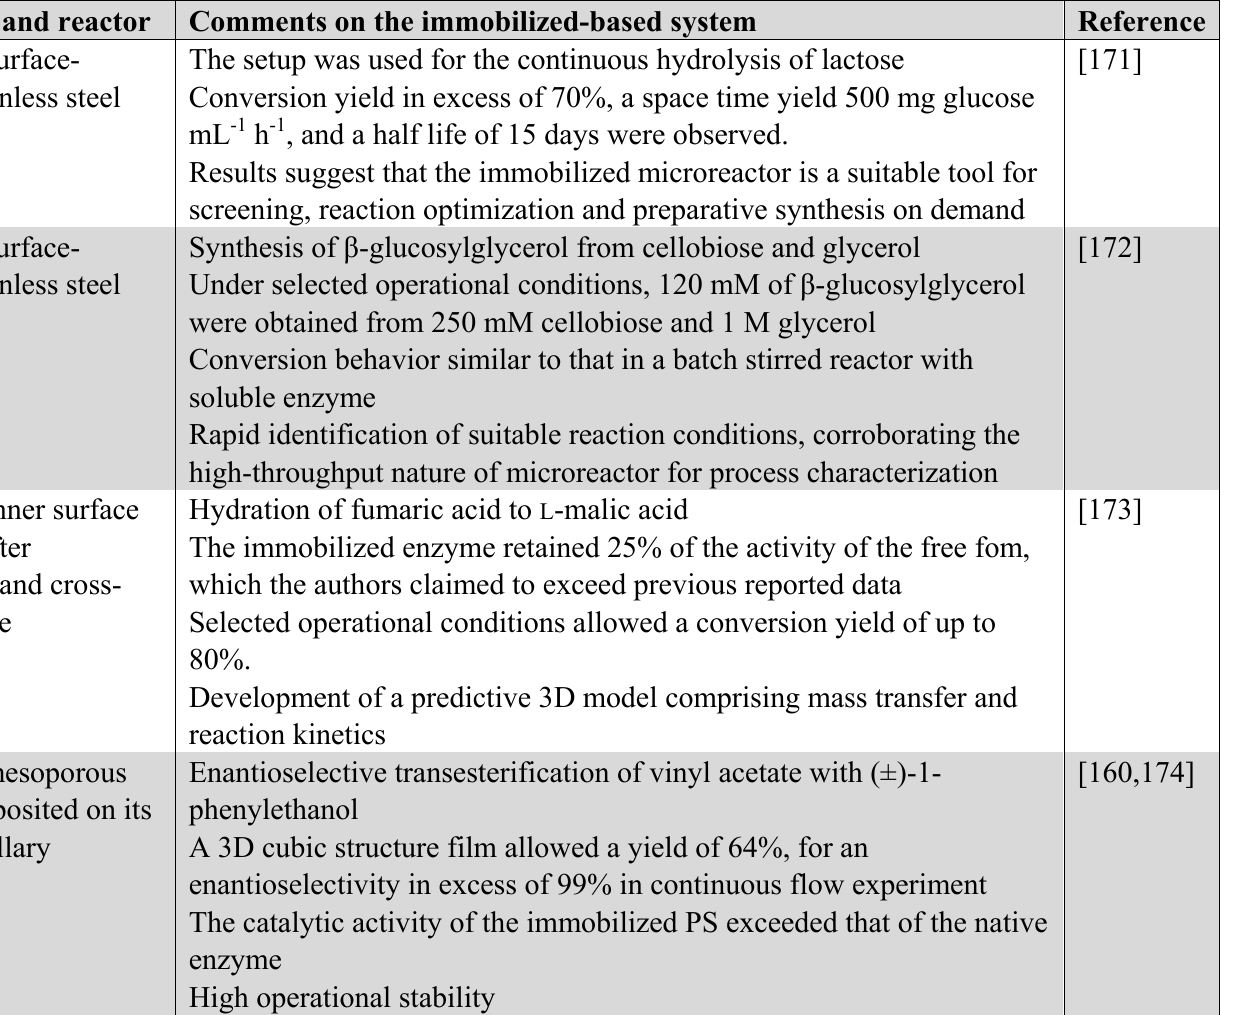
Table 3. Coated-wall type microreactor: some case